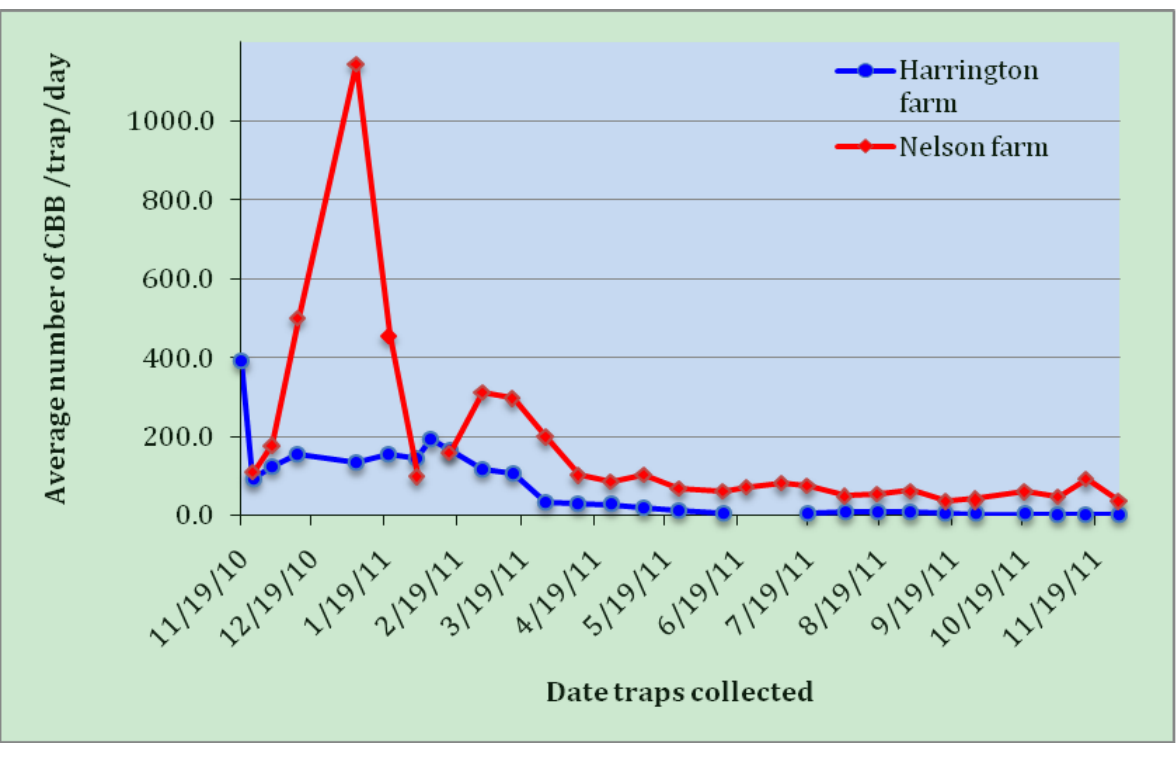
Figure 6. Average number of adult coffee berry borers captured per trap per day on two Kona coffee farms during the first year following coffee berry borer (CBB) invasion in